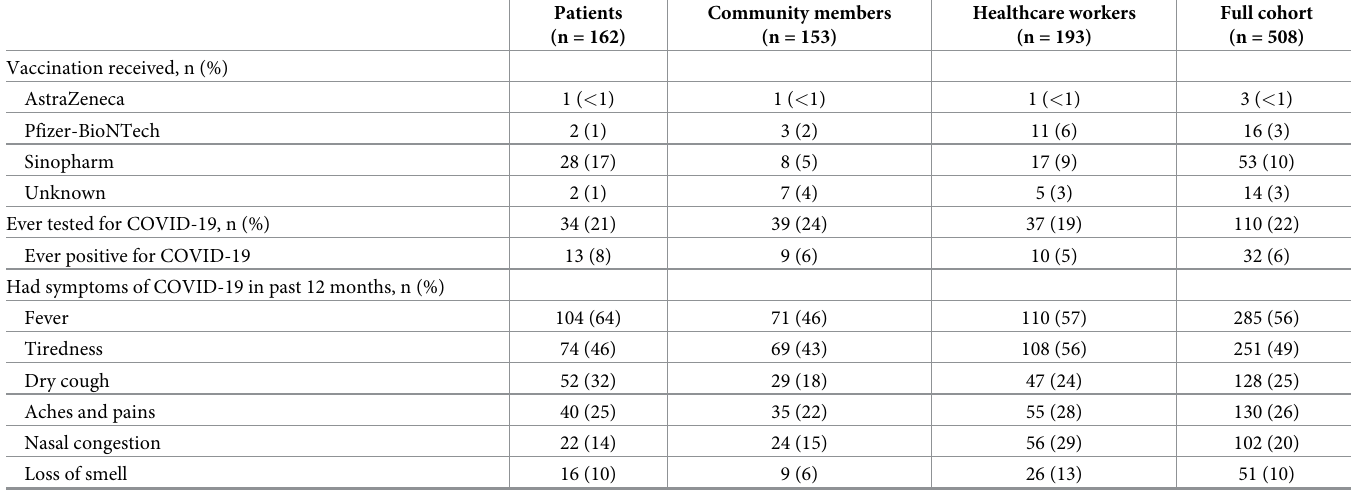
Table 2. Participant attitudes and practices regarding